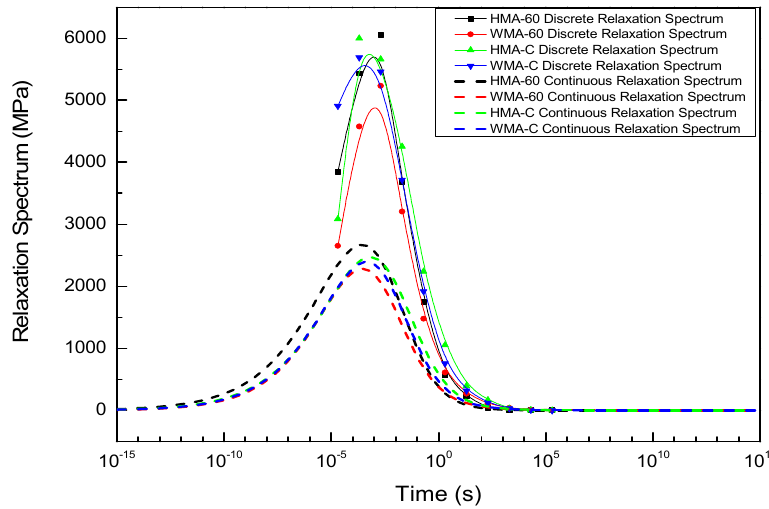
Figure 7. The discrete and continuous relaxation spectrum of asphalt mixture.